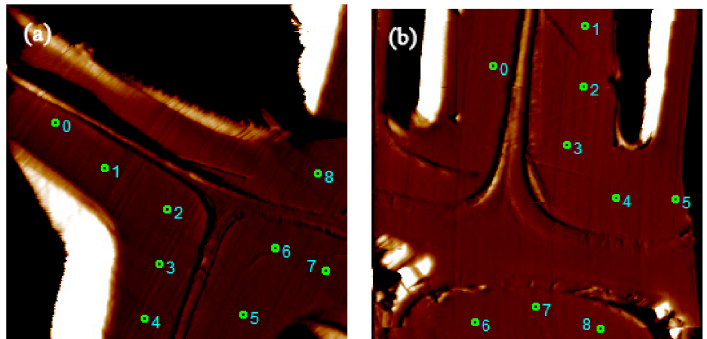
Figure 6. Nanoindentation images of Chinese fir marked with measurement location. ( a ) control sample, ( b ) PF-1-Cu sample.